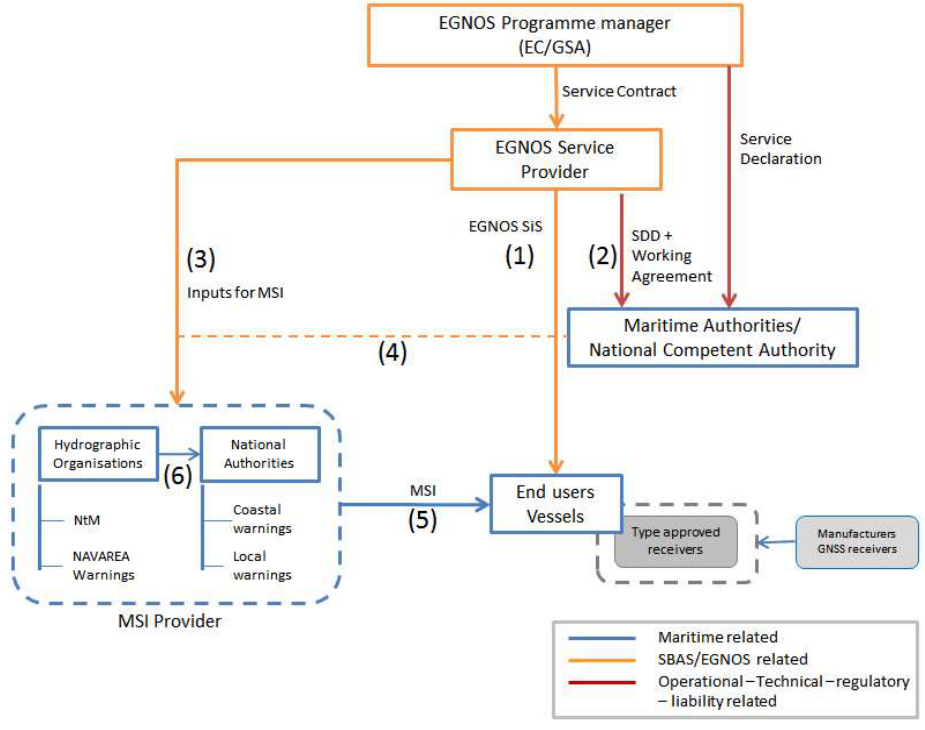
Figure 5. High-level service provision model as introduced in the IALA G.1152 [6], Section 6. SBAS/EGNOS Maritime Safety Information (MSI)